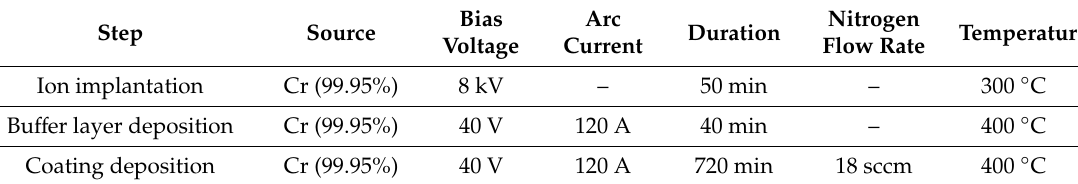
Table 2. Deposition parameters of CrN coating.